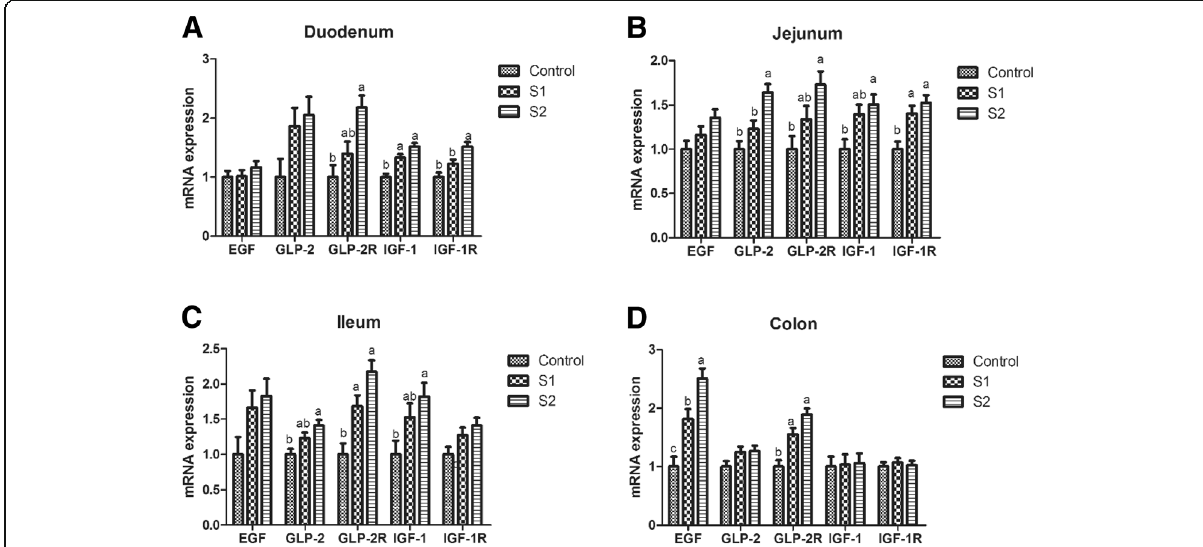
Fig. 3 Effect of gastric infusion of SCFA on the relative mRNA expressions of intestinal development-related genes in duodenum, jejunum, ileum, and colon of weaned piglets. S1, pigs treated with SCFA (acetic, propionic, and butyric acids; 20.04, 7.71, and 4.89 mM respectively); S2, pigs treated with SCFA (acetic, propionic, and butyric acids; 40.08, 15.41, and 9.78 mM respectively). a, b, means without a common superscript differ ( P < 0.05)